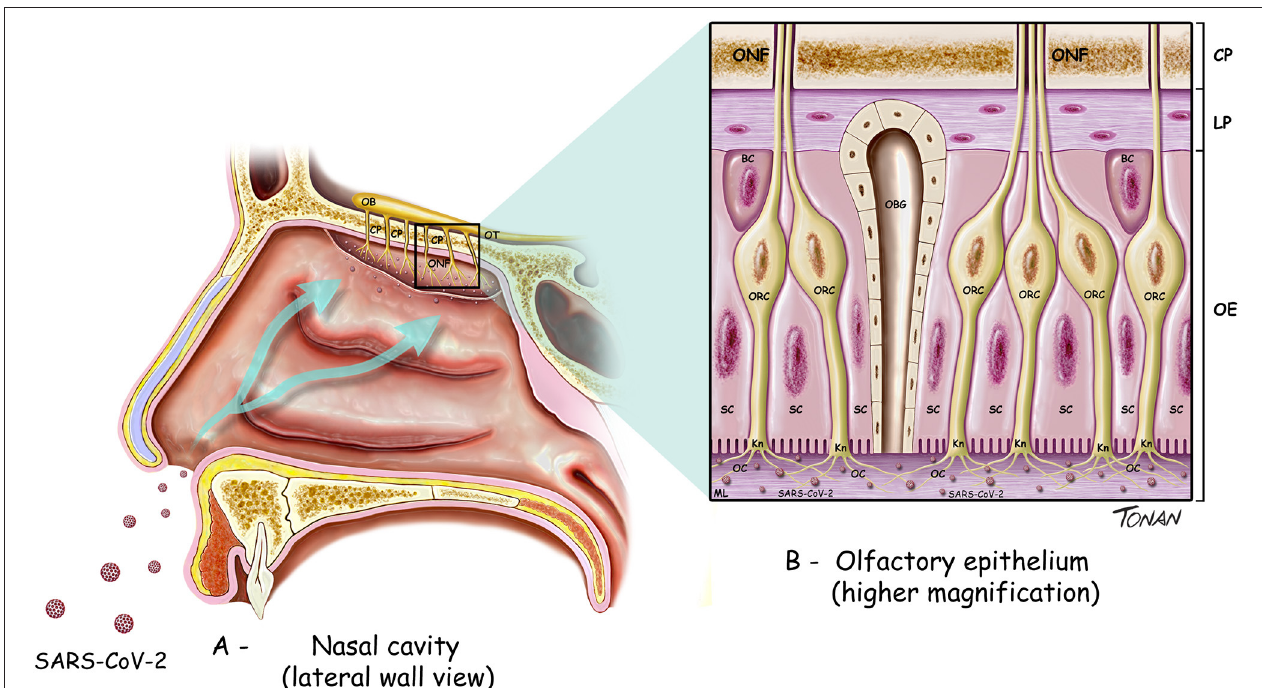
FIGURE 1 | Diagram illustrating the cell types found in the olfactory bulb and part of the olfactory pathway. (A) OB, olfactory bulb; OT, olfactory tract; ONF, olfactory nerve fibers; CP, cribiform plate of ethmoid bone. (B) ONF, olfactory nerve fibers; CP, cribiform plate of ethmoid bone.; LP, lamina propria; OE, olfactory epithelium; BC, basal cells; SC, supporting (sustentacular) cells; OBG, olfactory Bowman’s gland; ORC, olfactory receptor cells; Kn, olfactory Knobs; OC, olfactory